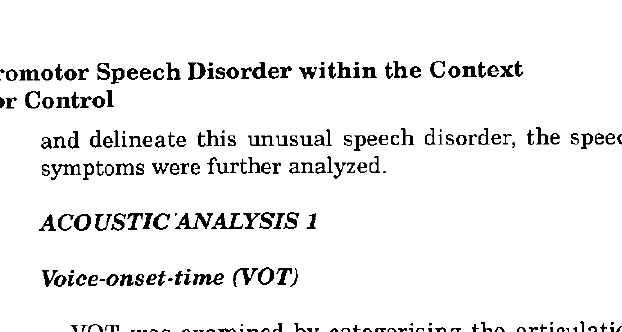
TABLE 2: Salient features of AOS and dysarthria with the presence and absence of feature in speech of the